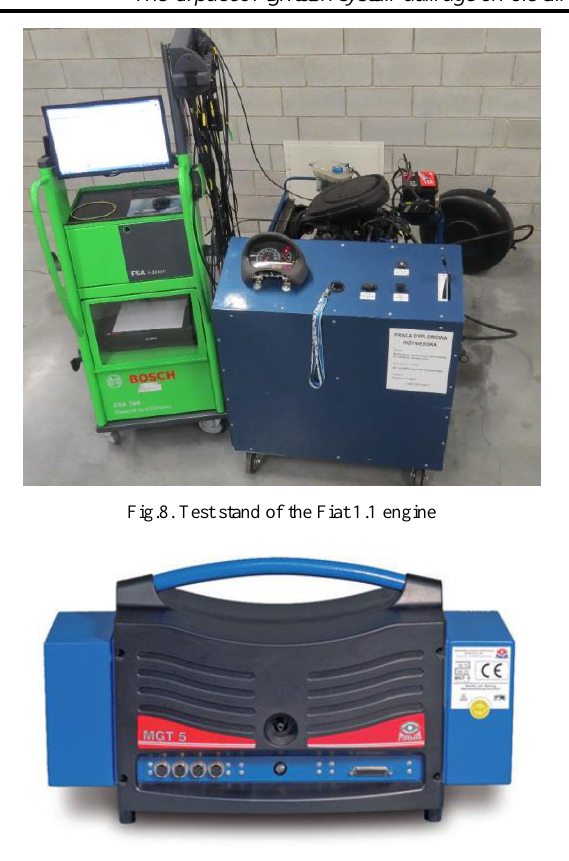
Fig. 9. MAHA MGT 5 exhaust gas analyzer